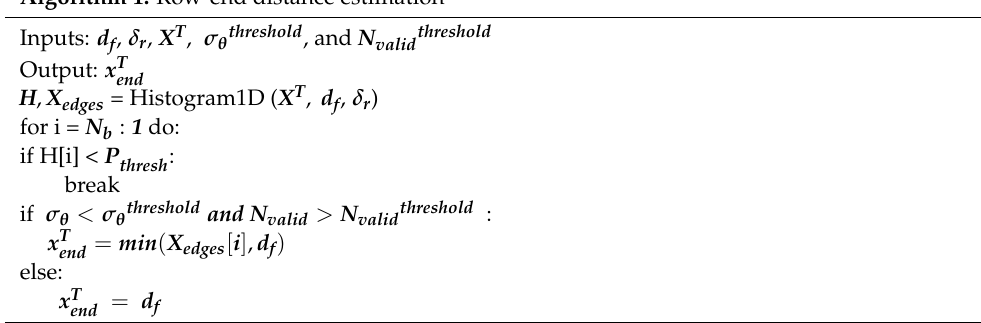
Algorithm 1: Row-end distance estimation